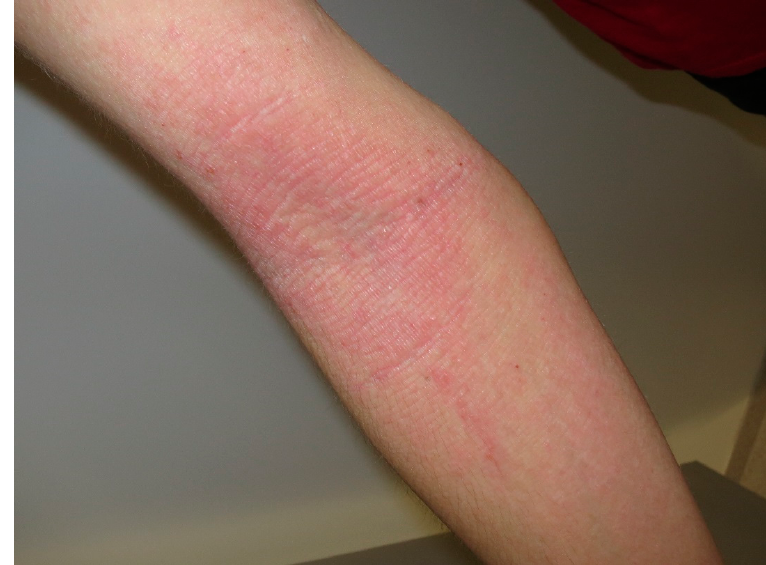
Figure 2. Atopic dermatitis. Excoriated bilateral erythematous scaling papules and plaques on the right flexor elbow surface.